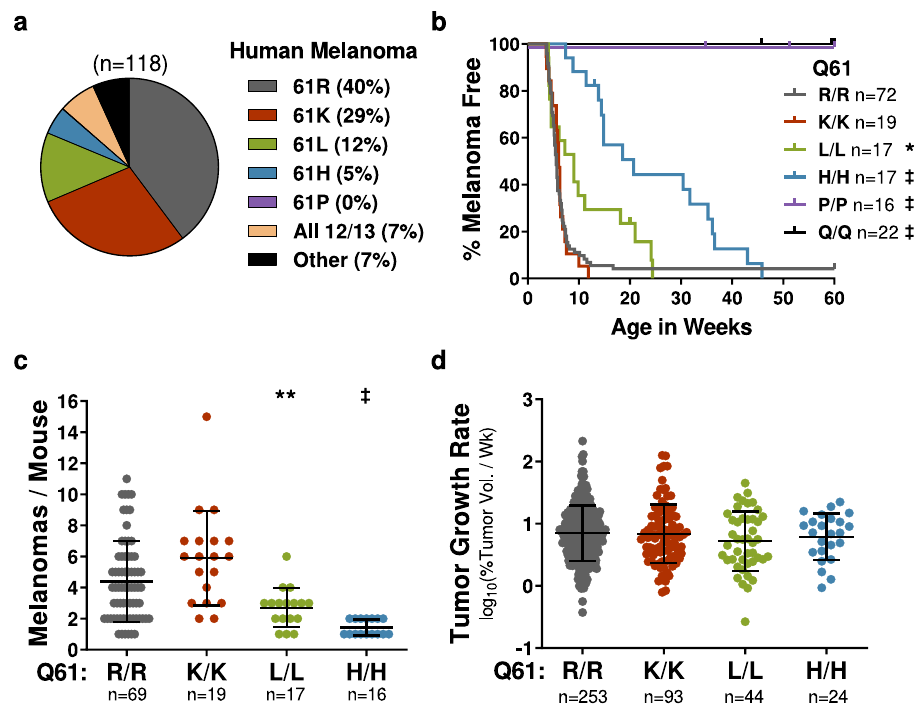
Fig. 1 Frequency of NRAS mutants in human melanoma parallels tumorigenic potential in mice. a Frequency of NRAS mutations in the TCGA PanCancer Atlas dataset for human cutaneous melanoma. Melanoma-free survival ( b ), total tumor burden ( c ), and tumor growth rates ( d ) for mice expressing the indicated melanocyte-speci fi c NRAS mutants. Tumor burden and growth rate data are presented as mean values + / − SD. The following number biologically independent animals were evaluated per genotype (61R = 72, 61K = 19, 61L = 17, 61H = 17, 61P = 16, 61Q = 22). Log-rank (Mantel – Cox) ( b ) or ANOVA ( c , d ) with a Tukey ’ s multiple comparisons test was used to compare measurements between each genotype. TN X/X samples statistically different from TN 61R/R are indicated in the fi gure. Adjusted p -values for all comparisons can be found in Supplementary Table 1a. * p < 0.05, ** p < 0.01, ‡ p < 0.0001. Source data are provided as a Source Data fi